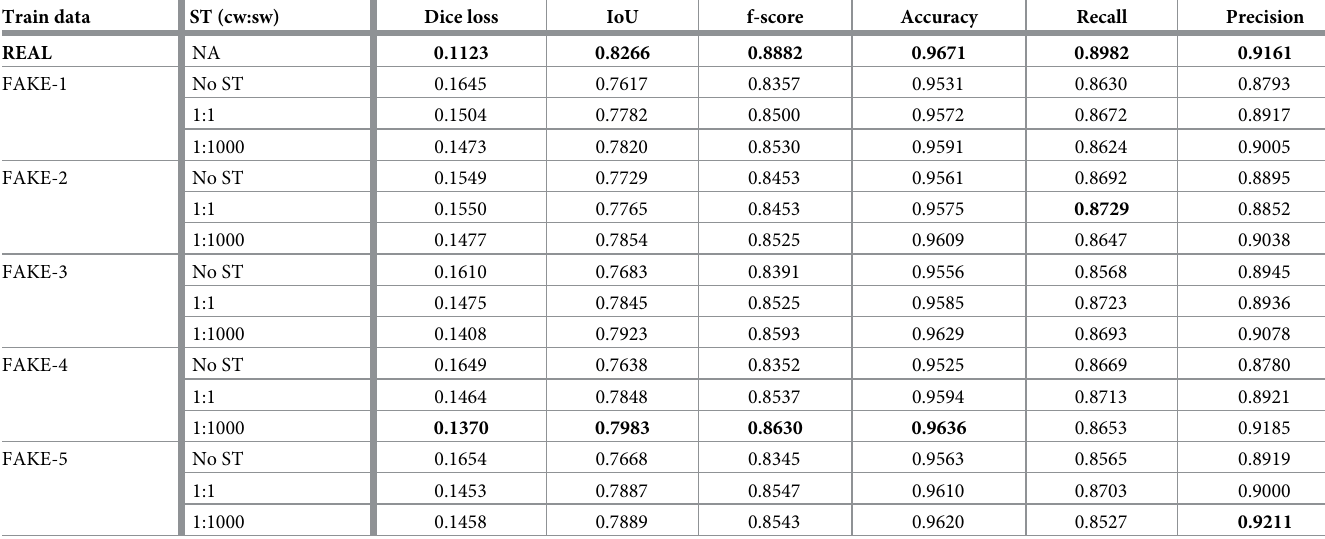
Table 2. Three-fold average of basic metrics to compare real versus synthetic performance with UNet++ and the effect of style-transfers performance.